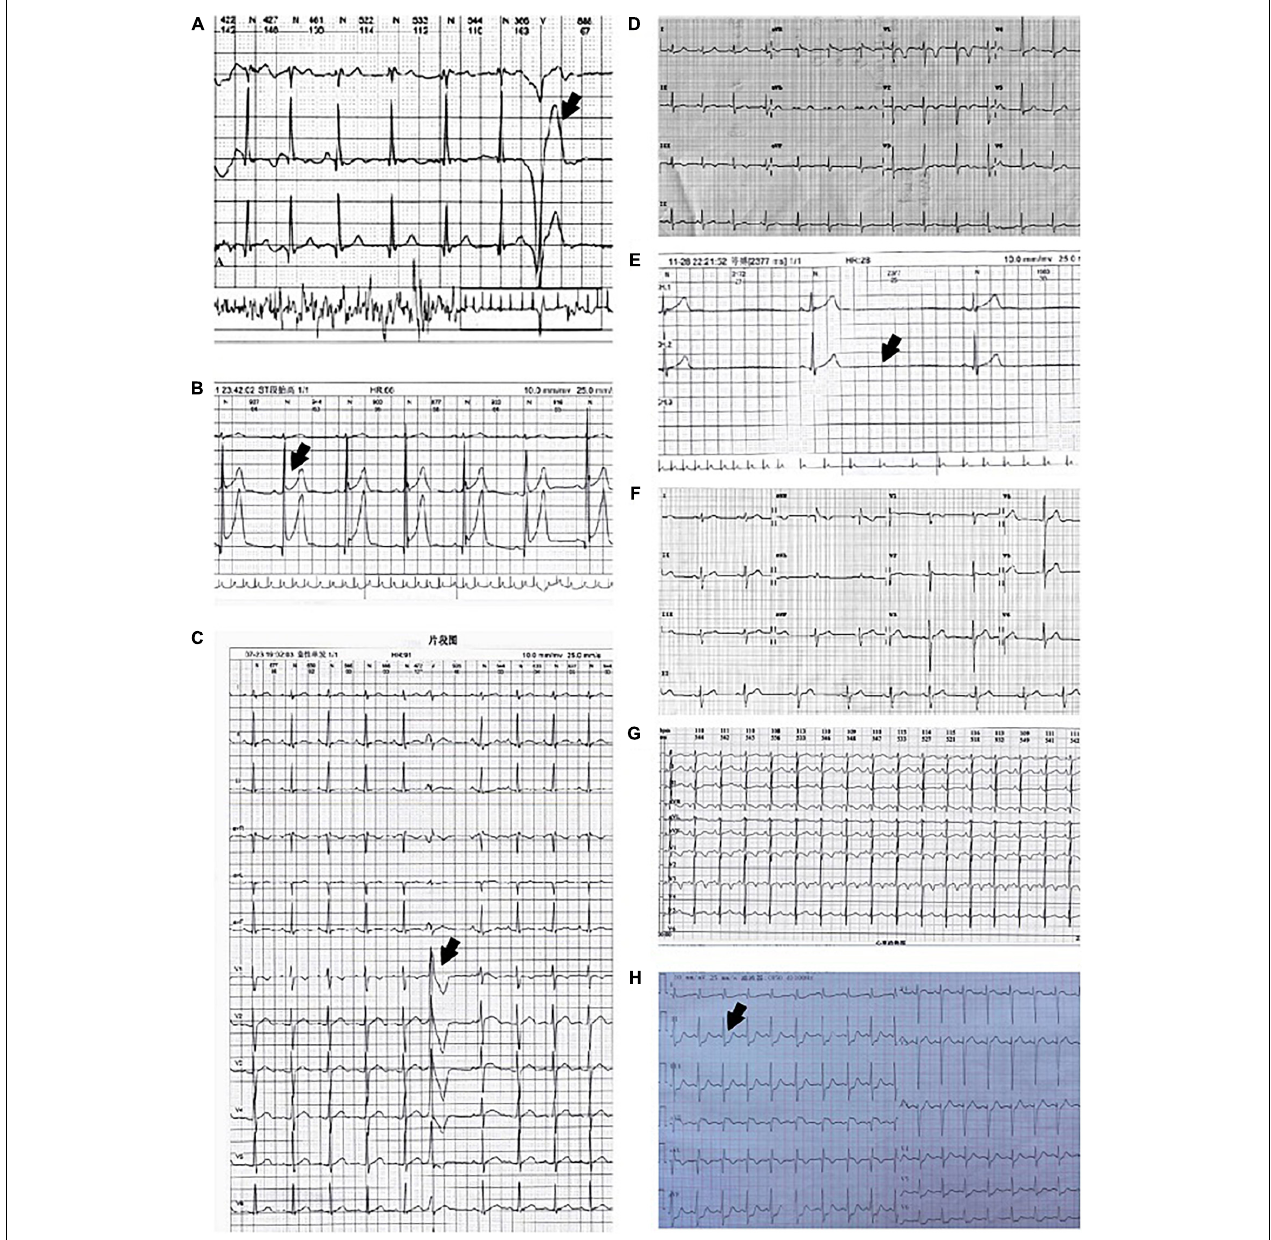
FIGURE 1 | Electrocardiogram (ECG)/Holter ECG of eight patients. (A) Single premature ventricular contraction in Patient 1. (B) ST-T elevated in patient 2. (C) Single premature ventricular contraction in patient 3. (D) Normal ECG of patient 4. (E) Sinus arrest in patient 5. (F) Left axis deviation in patient 6. (G) QTc 0.50 s in patient 7. (H) ST-T depressed in patient